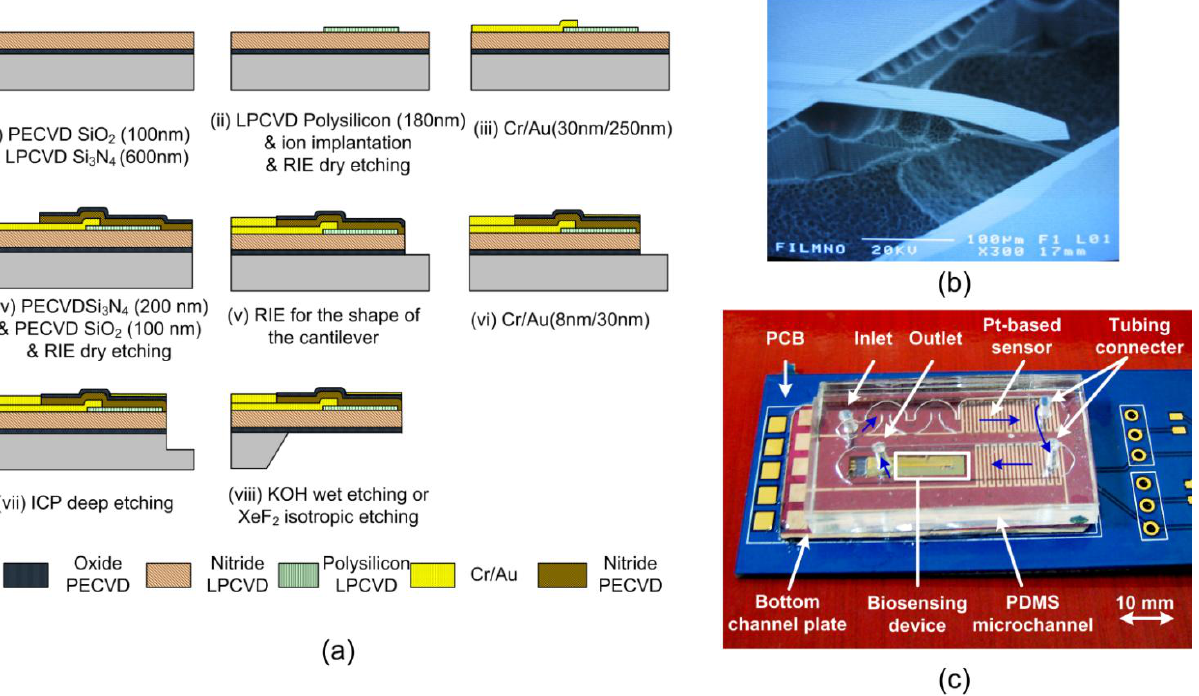
Figure 1. ( a ) Fabrication process of a single free-standing, thermally steady piezoresistive microcantilever for biosensing applications; ( b ) The SEM picture of the single free-standing piezoresistive microcantilever with no reference microcantilever; ( c ) Photograph of the electrically detected sensor-inside packaged micro channel